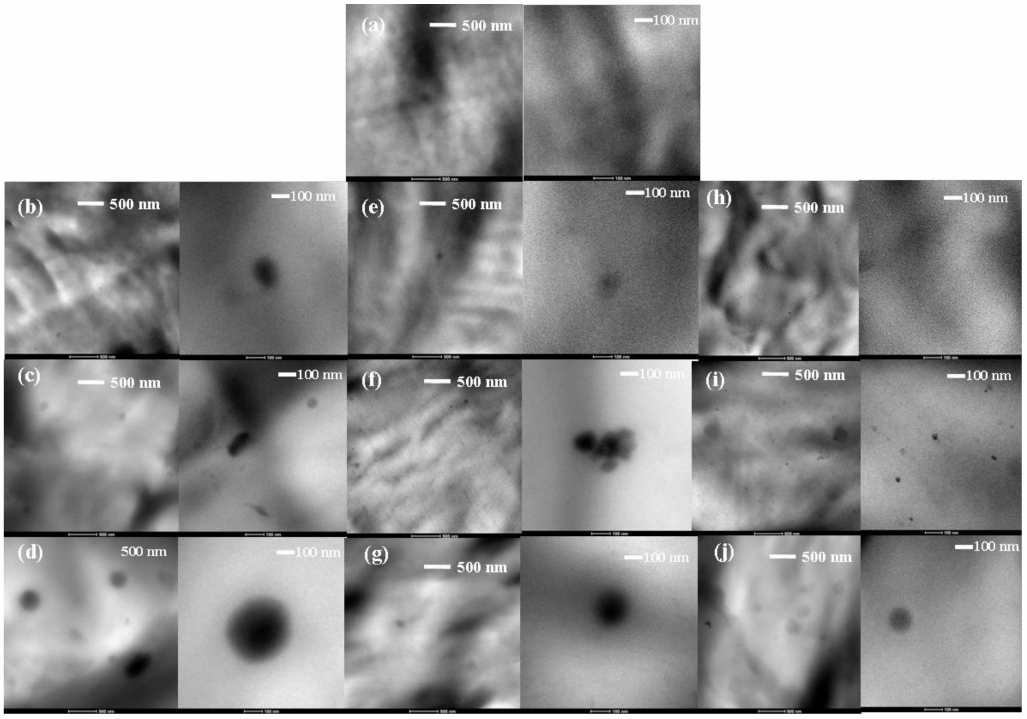
Figure 5. TEM micrographs of solution blended PCL/POSS